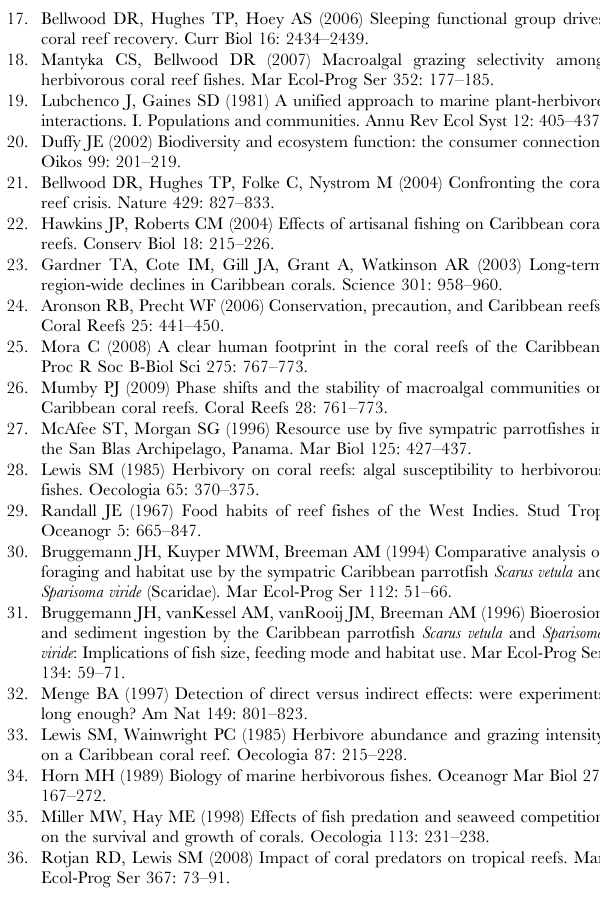
Table S2 Year 2 results from repeated measures, two-factor ANOVA of percent cover data. Significant effects are highlighted in